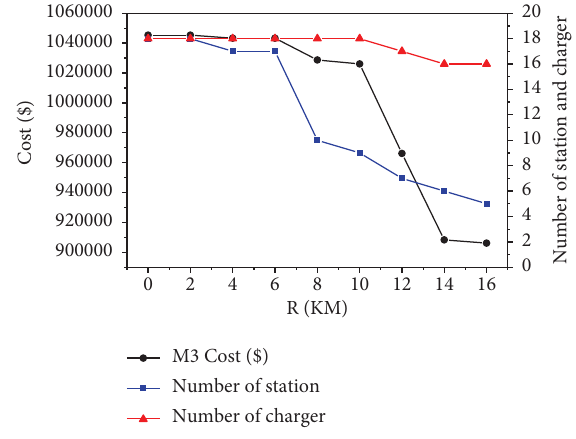
Figure 4: Model M